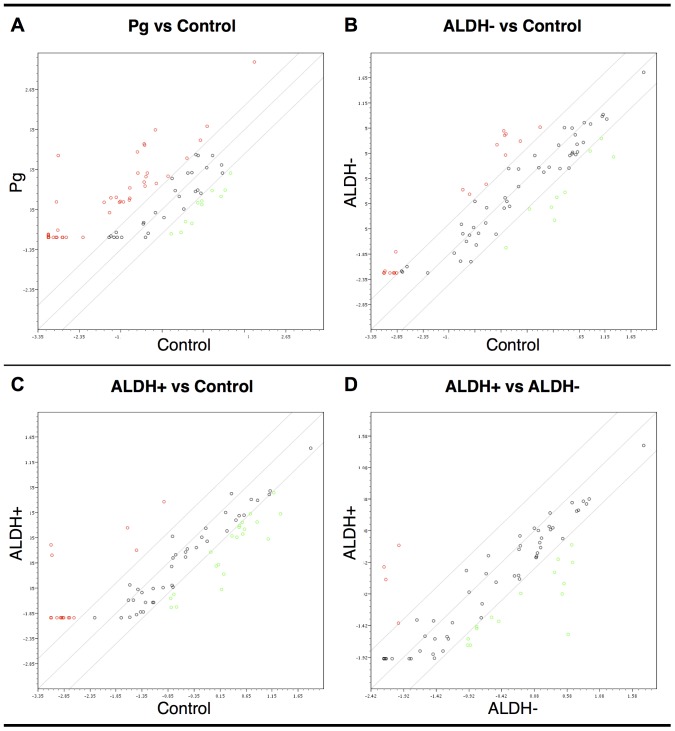
Comparative microRNA expression levels in MCF10A cells.Each scatter plot shows microRNA expression levels (logarithmic scale) for two experimental groups: cells exposed to progesterone treatment alone (Pg) vs non-irradiated cells (Control) (A), ALDH− cells (after irradiation and progesterone treatment) vs Control (B), ALDH+ cells (after irradiation and progesterone treatment) vs Control (C), ALDH+ cells vs ALDH− cells (D). The outer diagonal lines indicate 4-fold differences in microRNA expression. Each microRNA is represented by a circle.